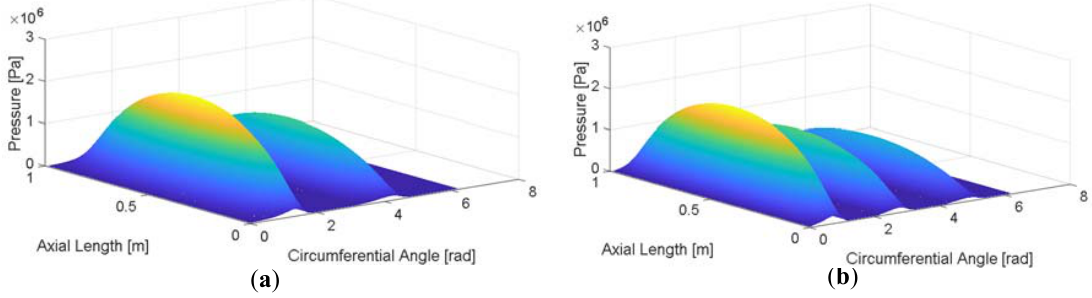
Figure 3. Pressure field distribution—( a ) Elliptical bearing; ( b ) Three-lobe bearing.